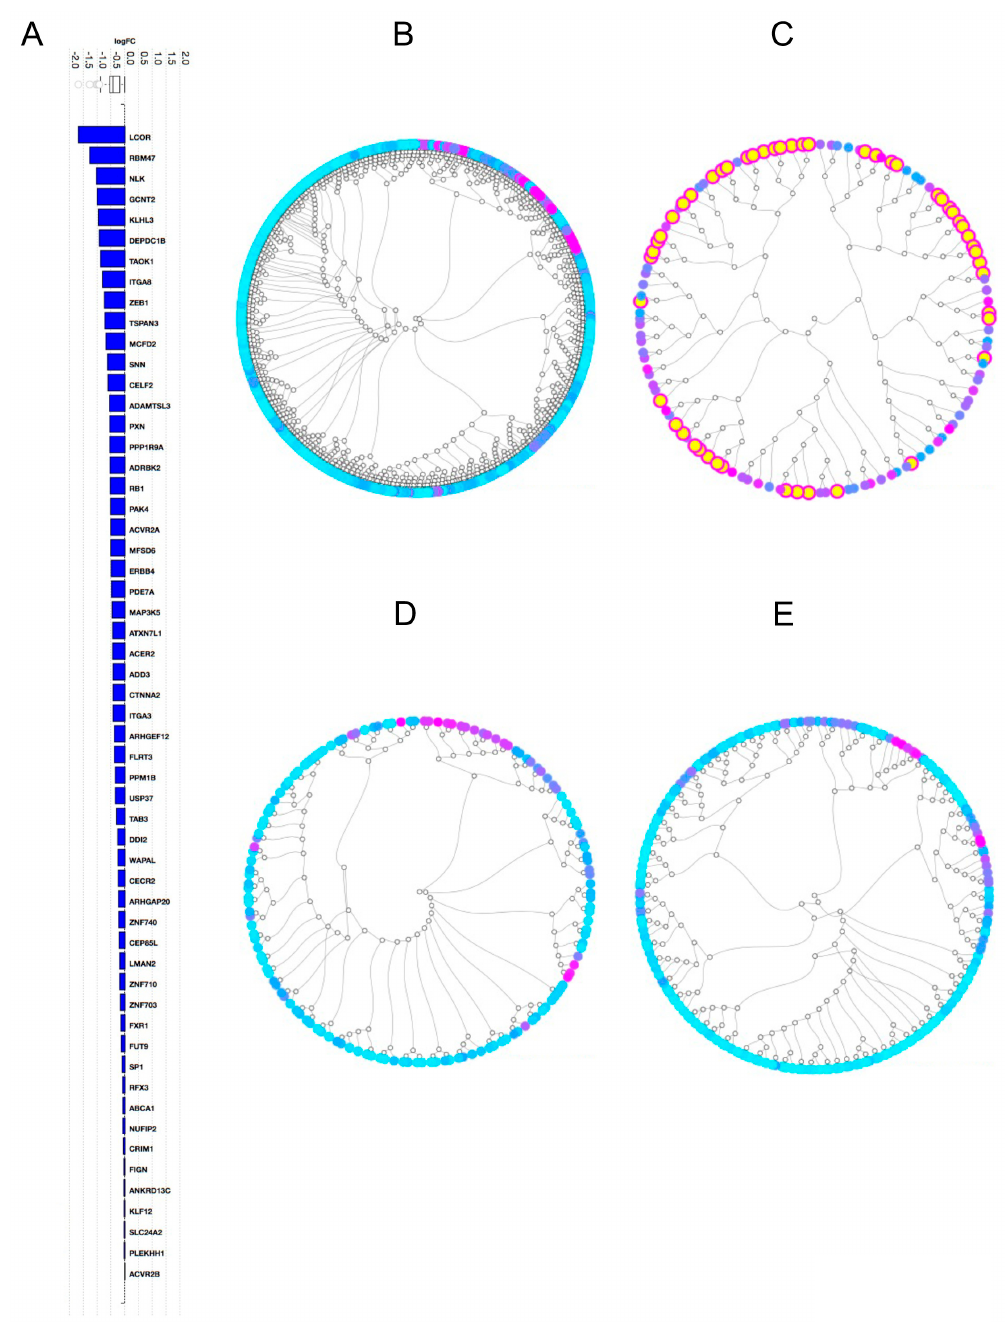
Figure 5. In silico predicted target gene analysis and pathway analysis using the iPathwayGuide. ( A ) Top downregulated target genes using all differentially expressed miRNAs; ( B – E ) dendrograms of all target genes using all differentially expressed miRNAs displaying biological processes ( B ); pathways ( C ); molecular functions ( D ); and cellular components ( E ). Each circle in the outer ring displays one entity, i.e., one biological process, pathway, molecular function, or cellular component. Inner lines and circles display connections between the different entities. Highlighted entities in panel C display the top 50 most statistically significant pathways. Overall statistical significance is displayed as a color range from green (less significant) to purple (more significant).